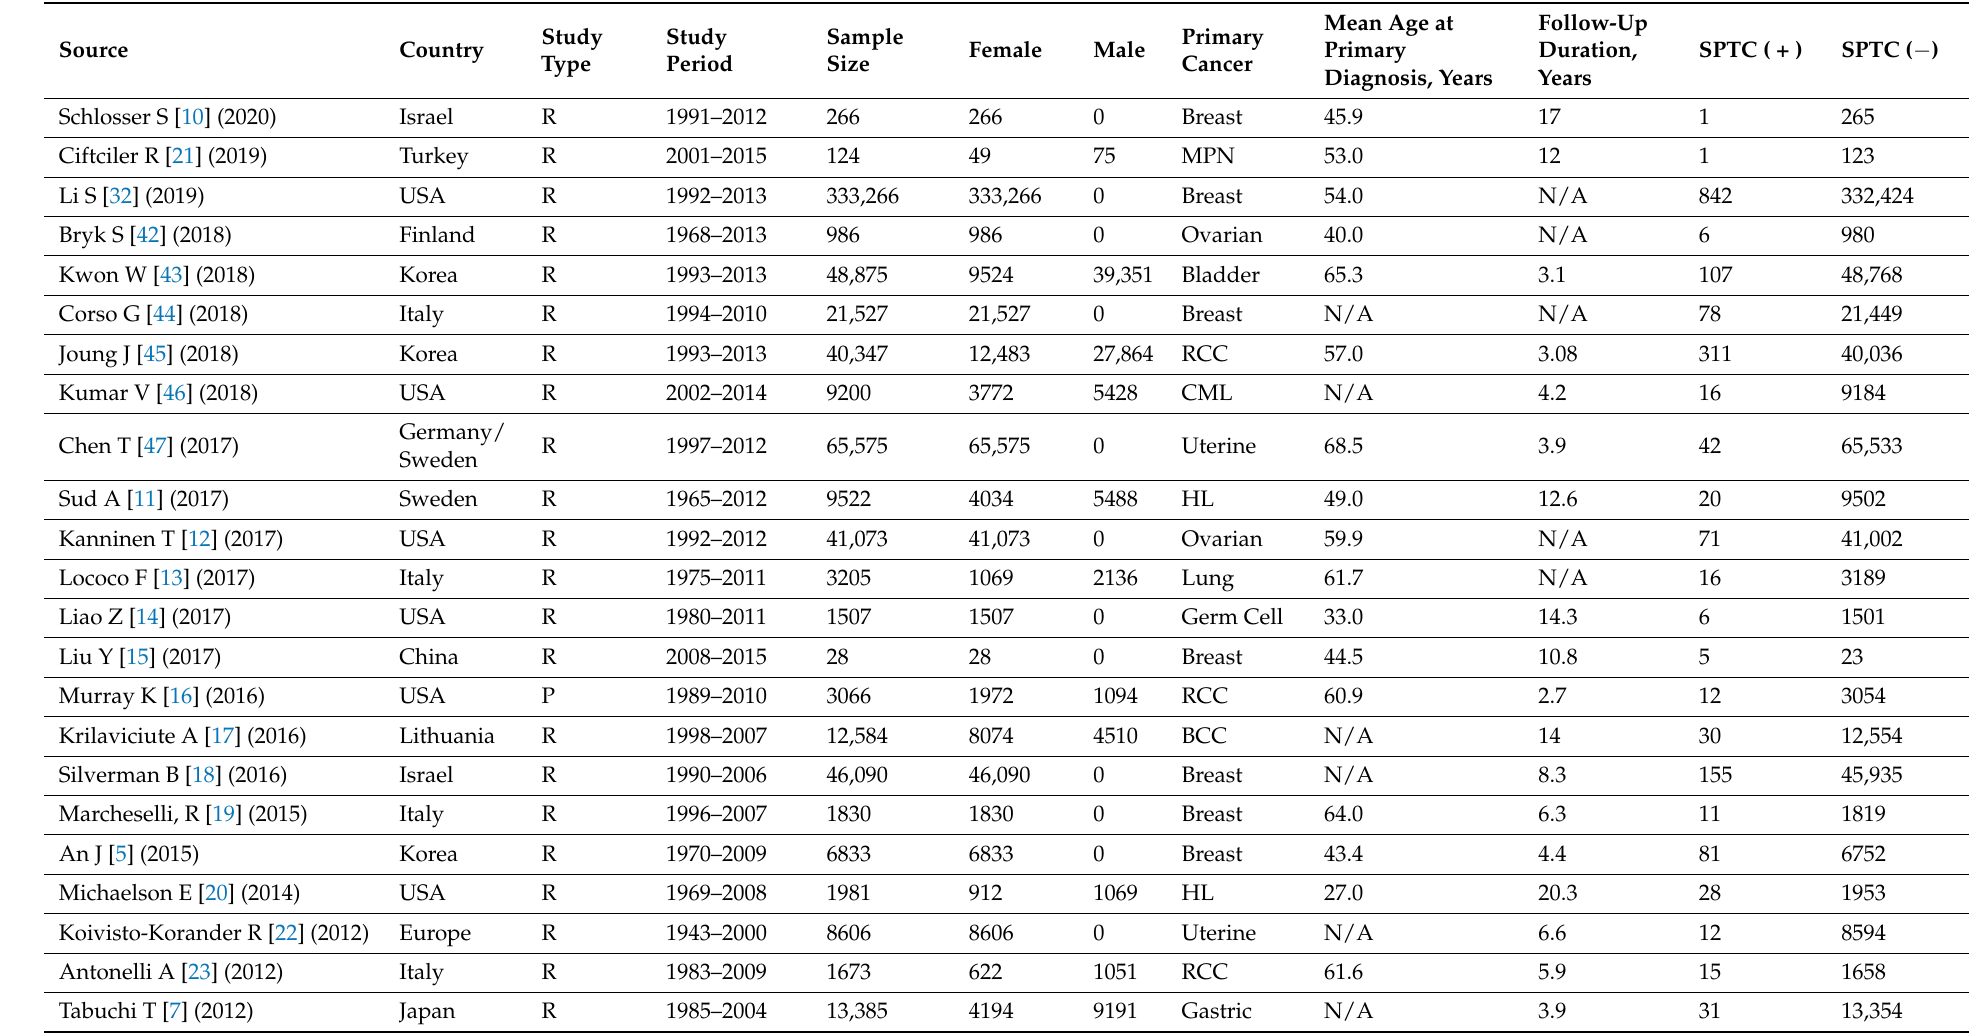
Table 1. Characteristics of the study